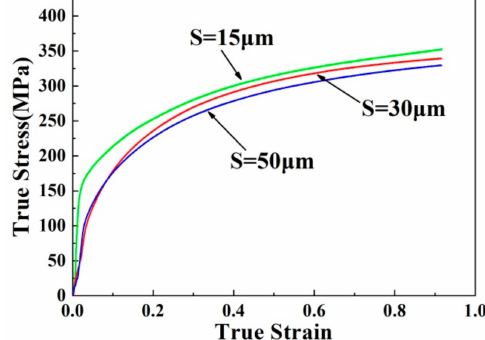
Figure 6. Flow stress of compressed samples with various grain